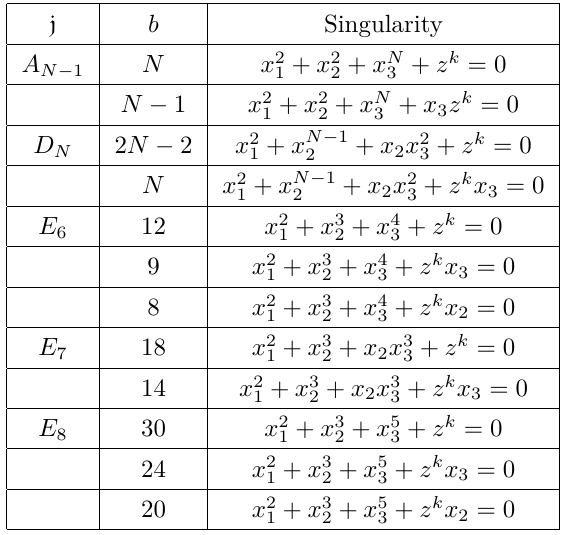
Table 1 . Three-fold isolated quasi-homogenous singularities of cDV type corresponding to the j ( b ) [ k ] irregular punctures of the regular-semisimple type in [16]. These 3d singularity is very useful in extracting the Coulomb branch spectrum, see [15].